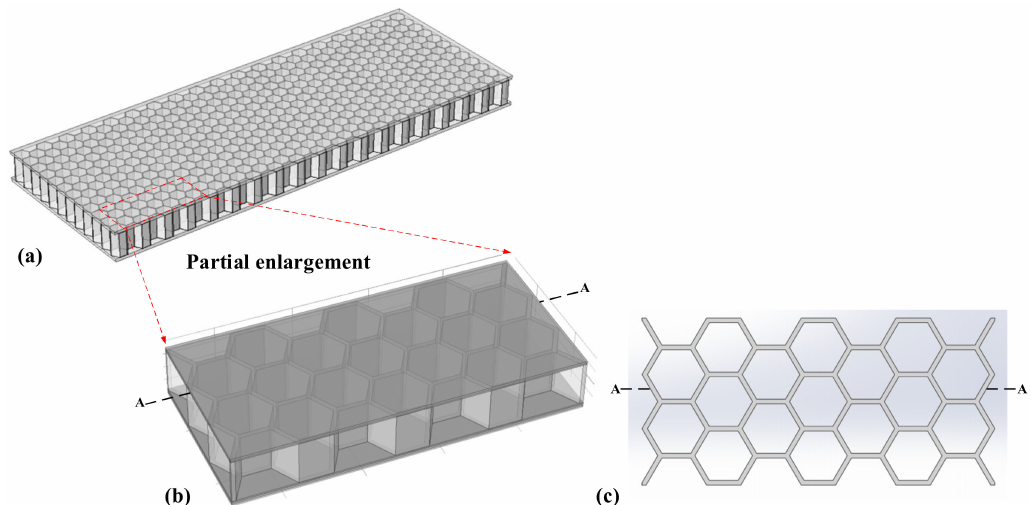
Figure 2. The honeycomb sandwich composite model simplification process. ( b ) is the partial enlargement of the honeycomb composite material of ( a ); ( c ) is a cross section of the honeycomb core of ( b